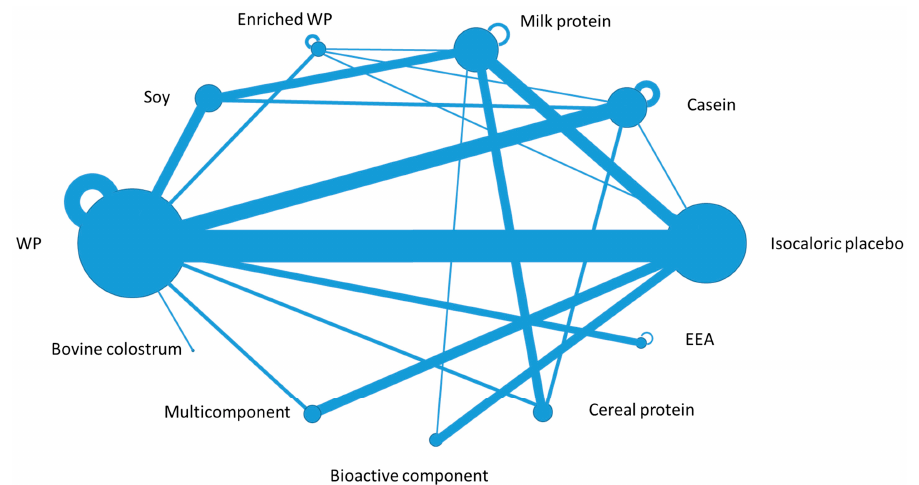
Figure 2. The network plot of the 11 intervention arms included in the randomized clinical trials (82 studies). The intervention arms are coded in the plot as nodes: each node size is proportional to the number of direct comparisons involving each intervention. The 20 lines between nodes represent direct comparisons driven by the trials; the line thickness is proportional to the number of studies where the direct comparison was performed. The additional semicircles over five nodes represent comparisons of di ff erent dosages within the same intervention (WP: Whey Proteins, EEA: Essential Amino